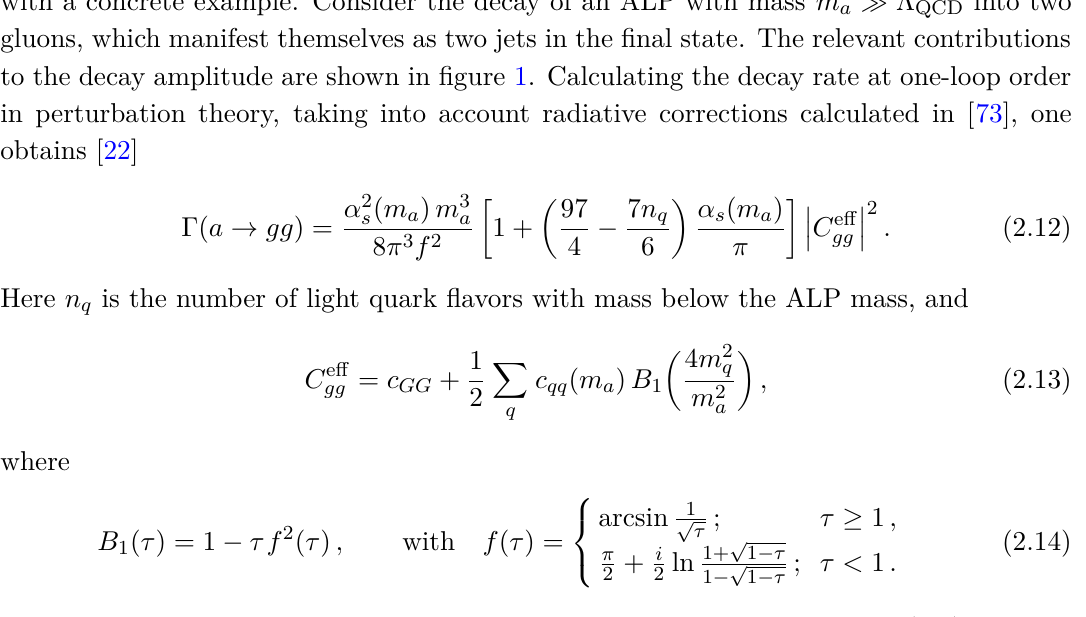
= 1 fixes the normalization of the SU( N ) F 2 = 3 is the number of colors, and N = 2 denotes the number of weak c L = 1 , Y = 2 , Y = − 1 , Y = − 1 and Y = − 1 denote the u e Q L d 6 3 3 2